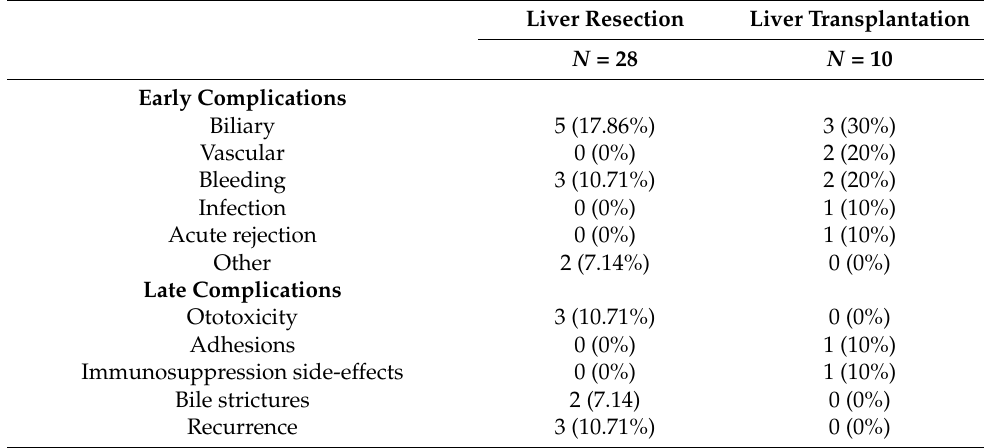
Table 2. Complications after Liver Transplantation and Liver Resection.